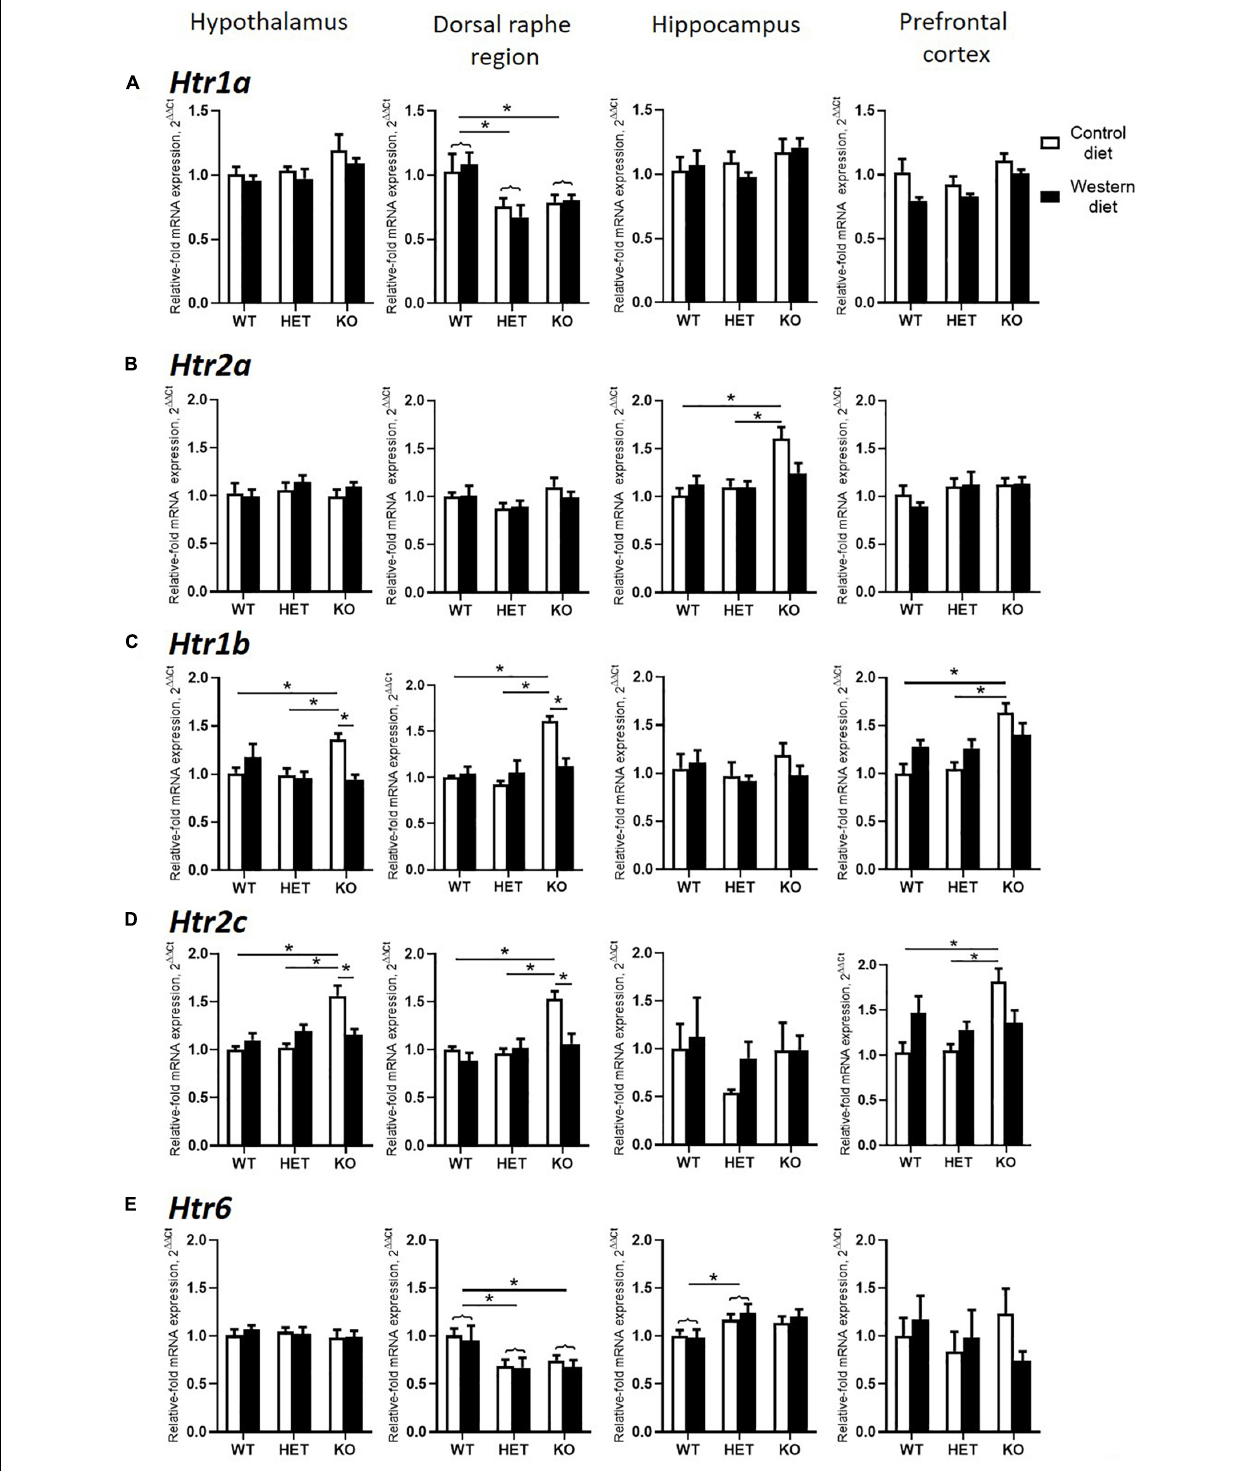
FIGURE 5 | Changes in brain expression of serotonin receptors by Western diet and SERT deficiency. (A,B) Htr1a and Htr2a expression in hypothalamus, dorsal raphe region, hippocampus, and prefrontal cortex. (C,D) Htr1 b and Htr2c expression in the brain. KO mice fed with CD compared to WT and HET mice fed with CD displayed significant increase in Htr1b and Htr2c expression levels in hypothalamus, dorsal raphe region, and prefrontal cortex. Compared to KO mice fed with CD, KO mice fed with WD demonstrated significant decrease in Htr1b and Htr2c expression levels in hypothalamus and dorsal raphe region. (E) Htr6 expression in hypothalamus, dorsal raphe region, hippocampus, and prefrontal cortex. * p < 0.05, two-way ANOVA and Tukey’s test, main genotype effect is marked with braces, six to seven animals per group were used. Data are shown as mean ± SEM.